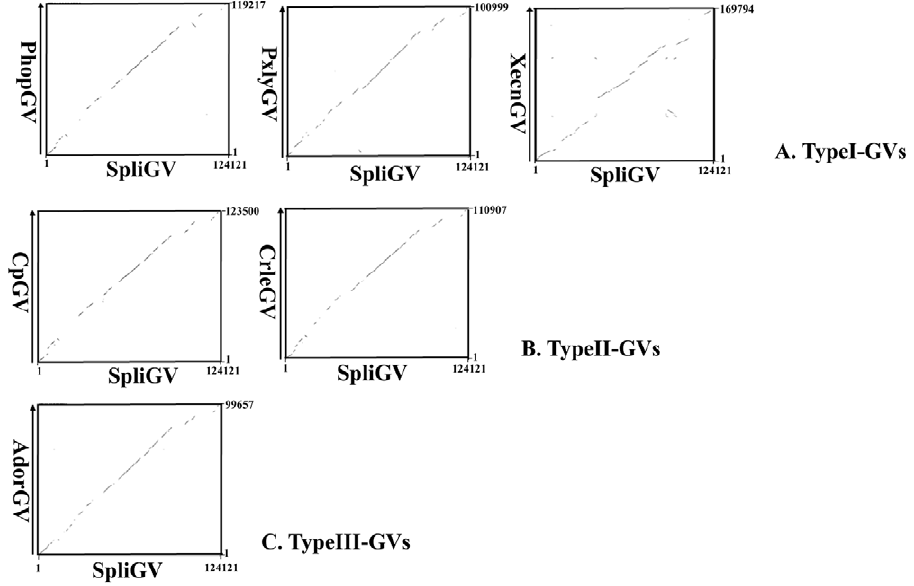
Figure 4. Nucleotide sequence comparison of the SpliGV genome and other GV genomes by matrix dot plot.